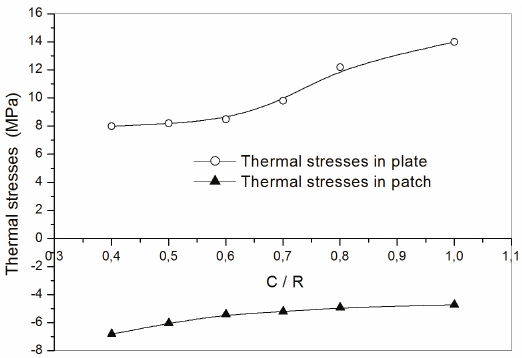
Figure 7. Variation of the mass gain according to the ratio c/R.